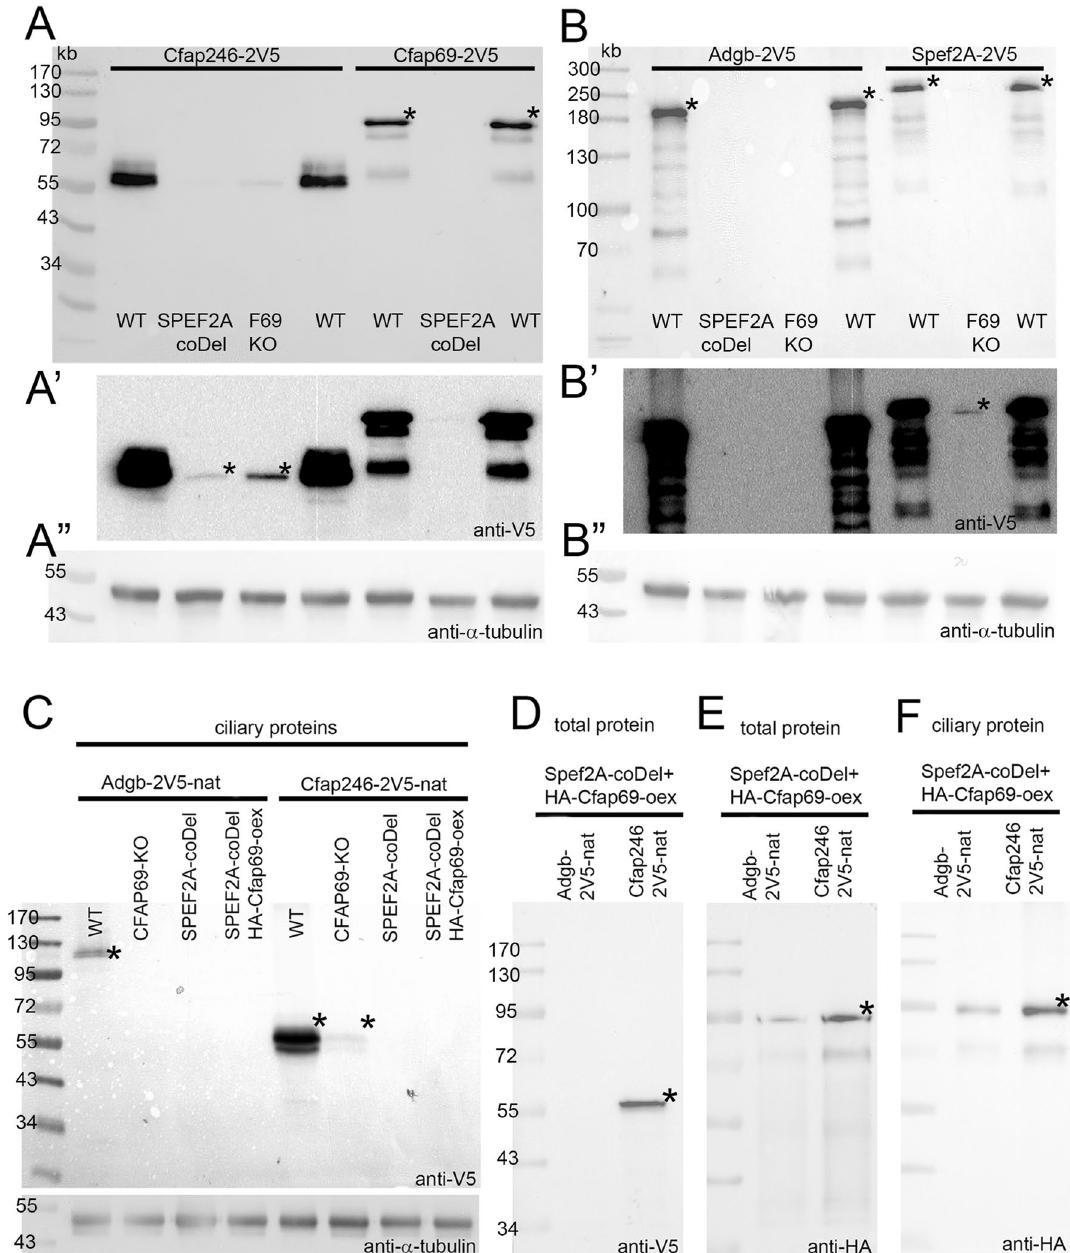
Figure 4. Lack of Spef2A or Cfap69 affects levels of other C1b/C1f subunits in cilia and total cell extract. The western blot analyses of the level of V5-tagged C1b/C1f proteins in total cell extract ( A , B ) and ciliary fraction ( C ). ( A’ , B’ ) the same blots as in ( A, B ) but after longer exposure. ( A” , B” ) corresponding blot stained with anti-α-tubulin antibodies (loading control). ( D - F) Overexpressed HA-Cfap69 is targeted to cilia ( F ) in SPEF2A- coDel mutant and partly stabilizes Cfap246-2V5 but not Adgb-2V5 ( D ). * indicates protein migrating according to the predicted molecular mass in the case of more than one band due to some protein degradation or weakly detected protein (A’, B’,